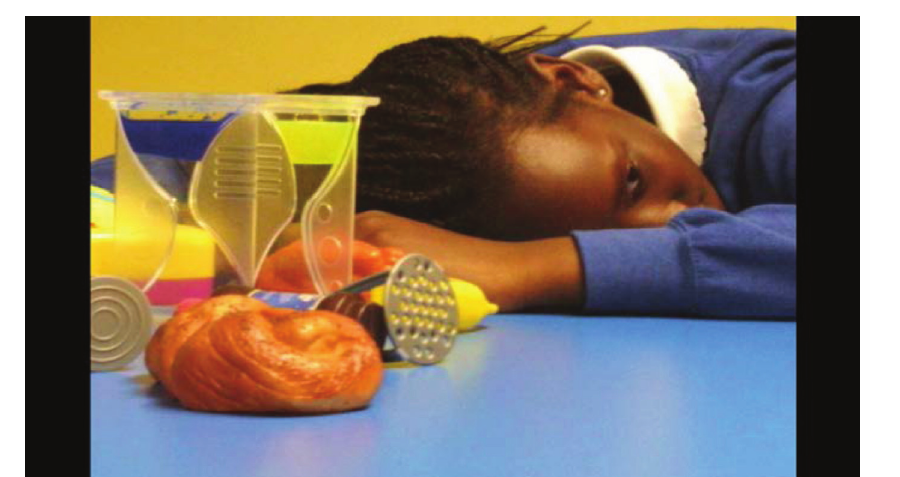
Figure 8: Khadija kills time in the detention room Towards the end of the process, Jamie spent two full days shooting with the group in order to help them capture some of the more challenging scenes, such as the climactic dance-off, which was recorded over several days. Much of the film’s material, however, remains footage that the group shot without the presence of a film-maker, such as the scene in which Arwyn passes nasty messages to Khadija (see Figure 9), and another accomplished classroom scene (which also, sadly, had to be cut due to the film’s running time) in which Khadija seems anxious about leaving school.